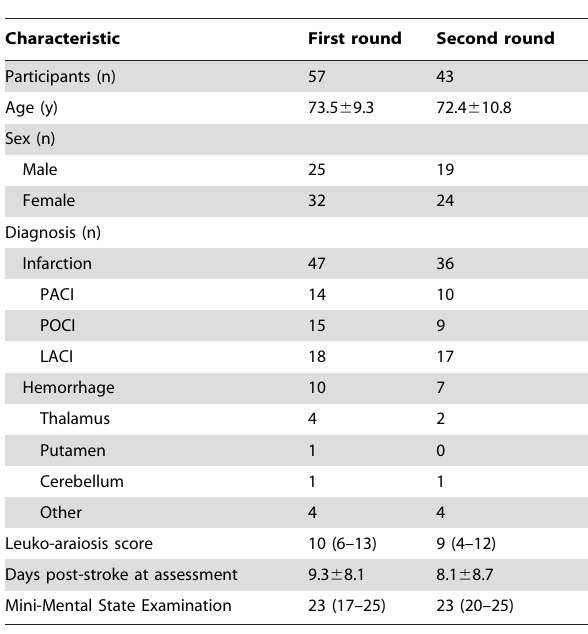
Table 1. Baseline Characteristics of the Study